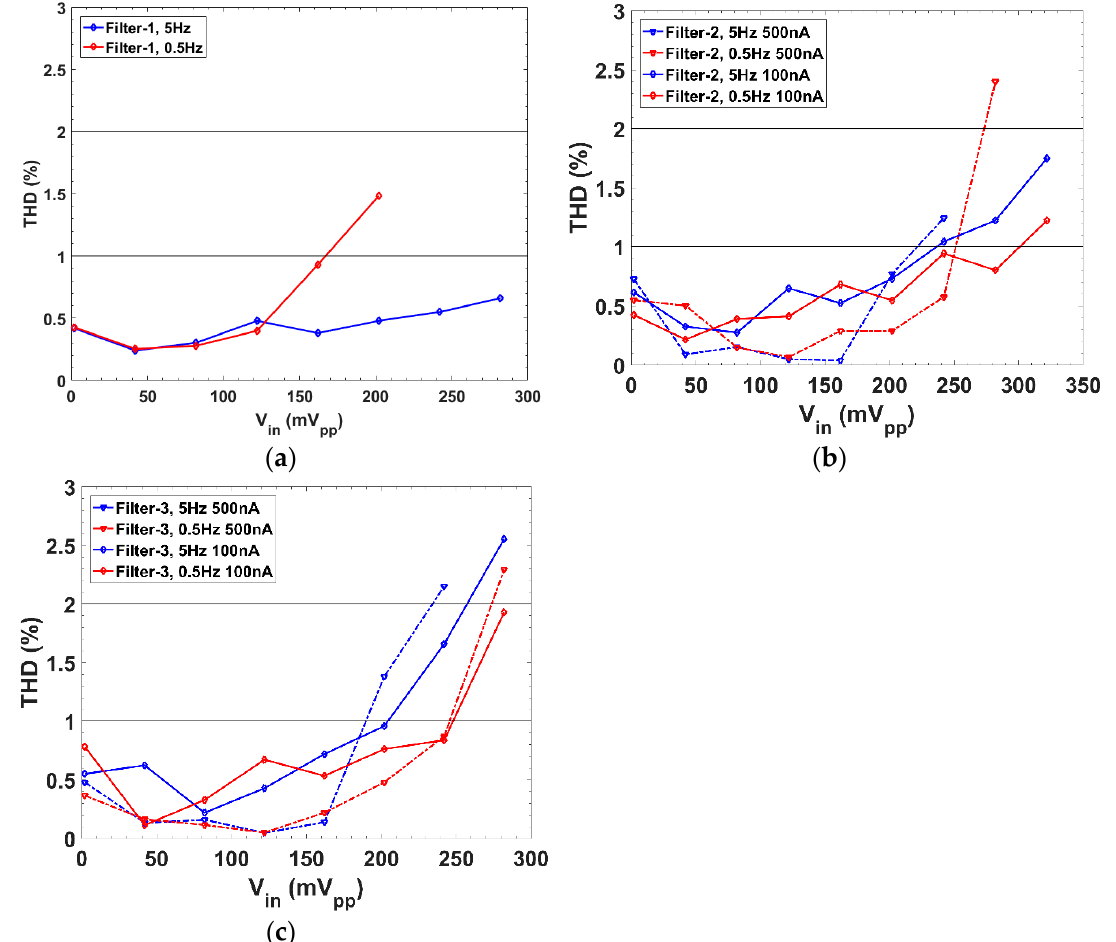
Figure 13. Harmonic distortion vs different amplitudes for: ( a ) Filter-1; ( b ) Filter-2; and ( c ) Filter-3.